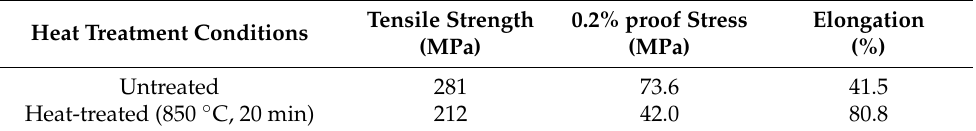
Figure 4. Typical stress–strain curves of untreated and heat-treated specimens. Table 5. Results of tensile test.